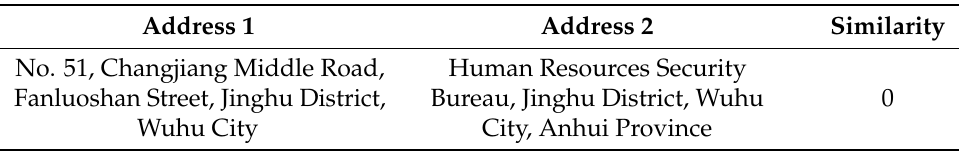
Table 8. A special case of failure